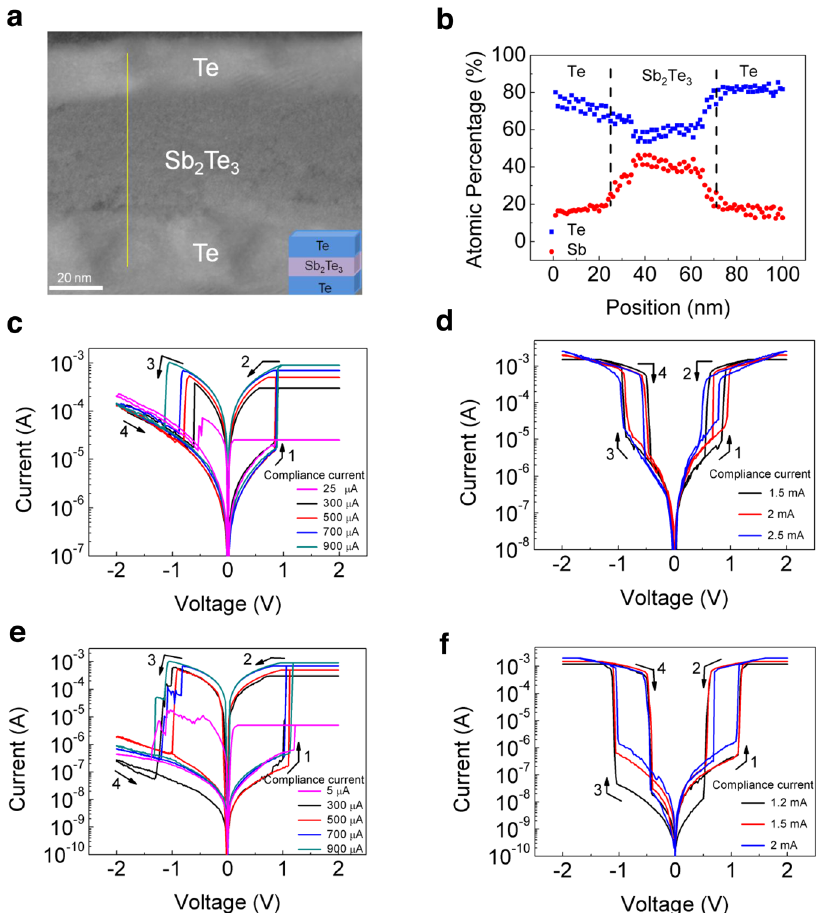
Fig. 1 Device structure and RS characteristics. ( a ) TEM image of the cross-section of the TST device. ( b ) Distribution of elements analyzed by EDS line scan along the yellow line denoted in ( a ). I – V curves of the Pt-protected TST device ( c ) in its NV-RS mode under various CCs ( d ) and in its V-RS mode under various CCs. I – V curves of the Gd protected TST device ( e ) in its NV-RS mode under various CCs ( f ) and in its V-RS mode under various